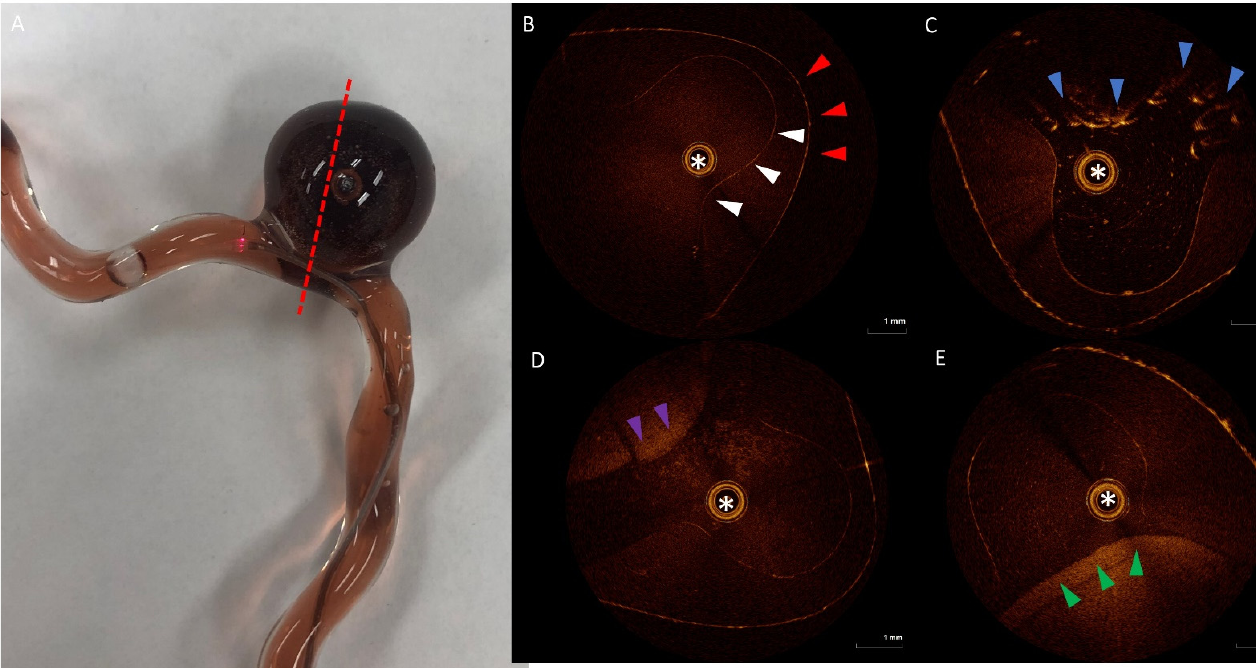
Figure 3. Cross-sectional OCT images of the model aneurysm ( A ) at the level of the dotted line. Pre-treatment OCT images demonstrate the parent vessel and the aneurysmal neck ( B ), with the white asterisk showing the imaging catheter, the white arrowheads showing the internal vessel wall of the model, and red arrowheads showing the external wall. The dome of the aneurysm is not visualized. After coiling ( C ), OCT shows the coil loops within the aneurysm (blue arrowheads) with a small gap in the neck area coverage. After PHP embolization using injection catheter lighting ( D ), there is a PHP mass (purple arrowheads) within the aneurysm but a gap between that mass and the aneurysm wall. After PHP injection using balloon lighting with intralipid ( E ), there is a PHP mass (green arrowheads) that fills the aneurysm and fully covers the aneurysm neck.